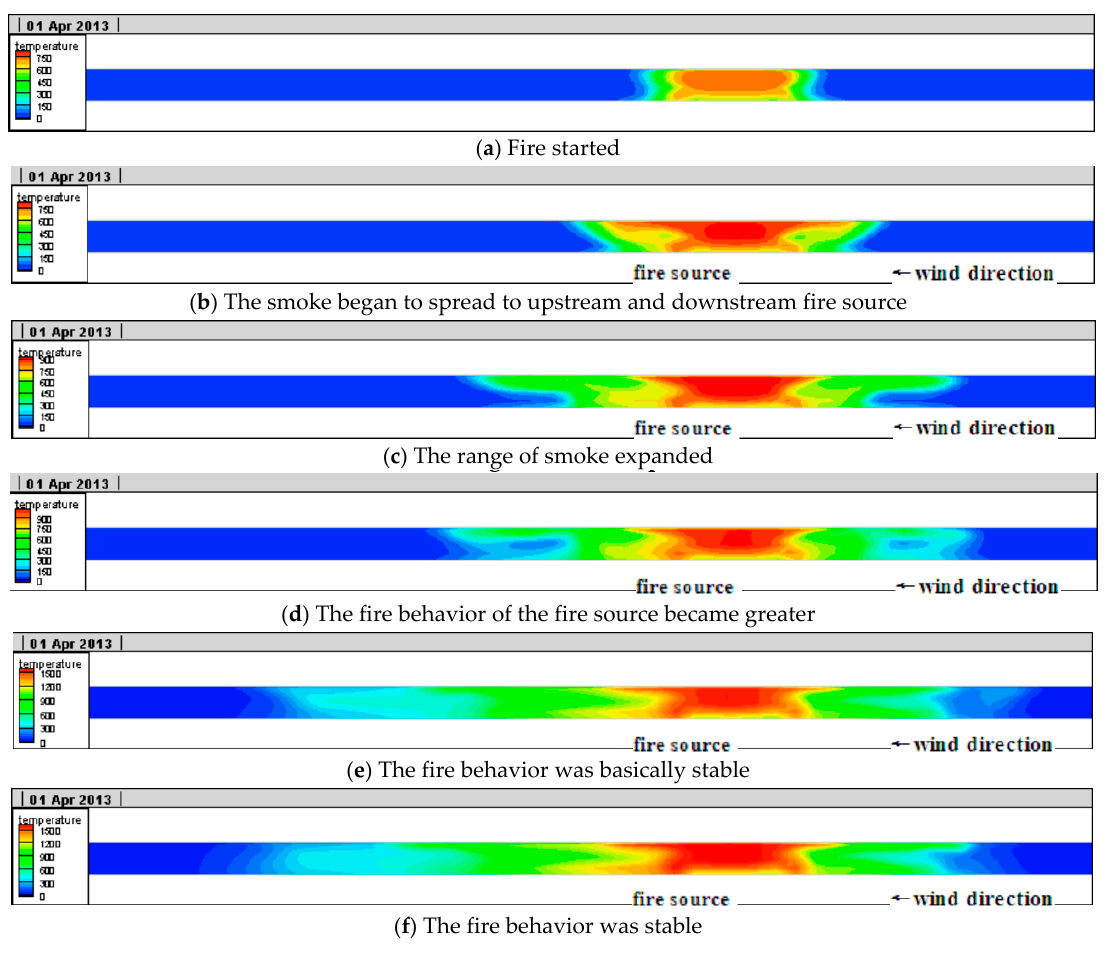
Figure 11. Longitudinal temperature in the tunnel.